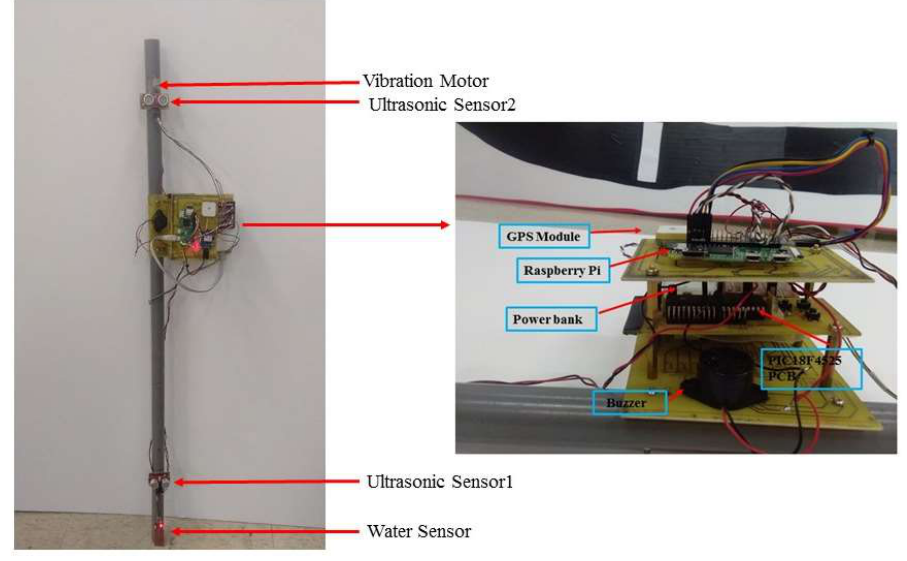
Figure 2. Real design of proposed walking stick.